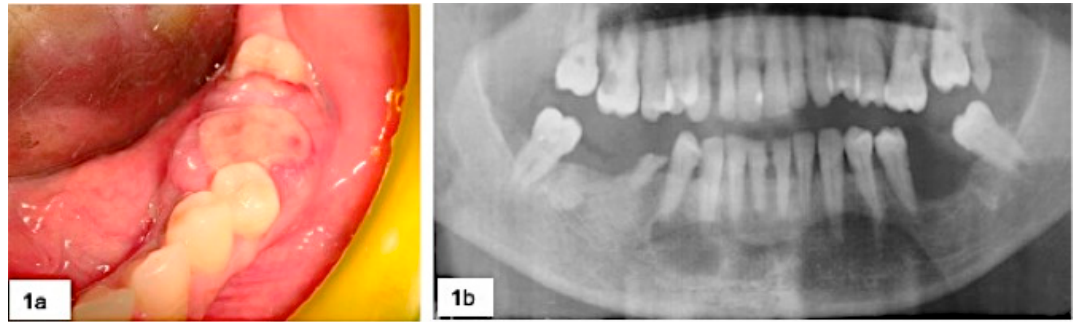
Figure 1. ( a ) Rapidly growing lesion in 3.6 region with severe horizontal bone loss and mobility of both 3.5 and 3.7 ( b ). Table 1. Clinical and radiological data of the lesions.